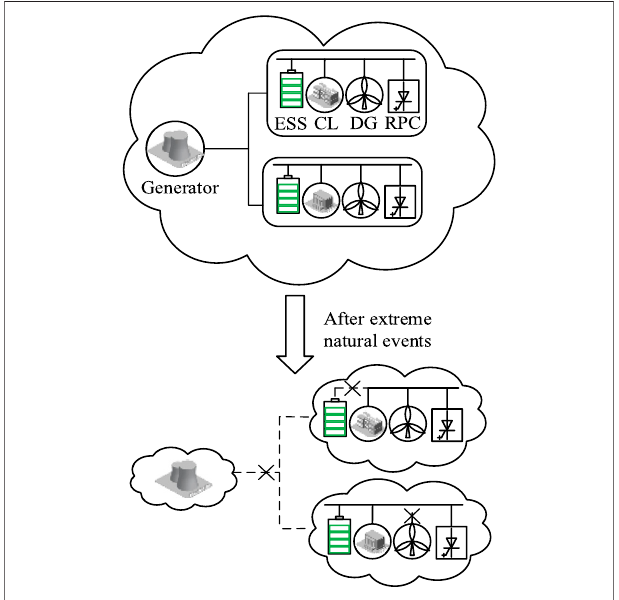
FIGURE 1 | Condition of distribution network after extreme natural